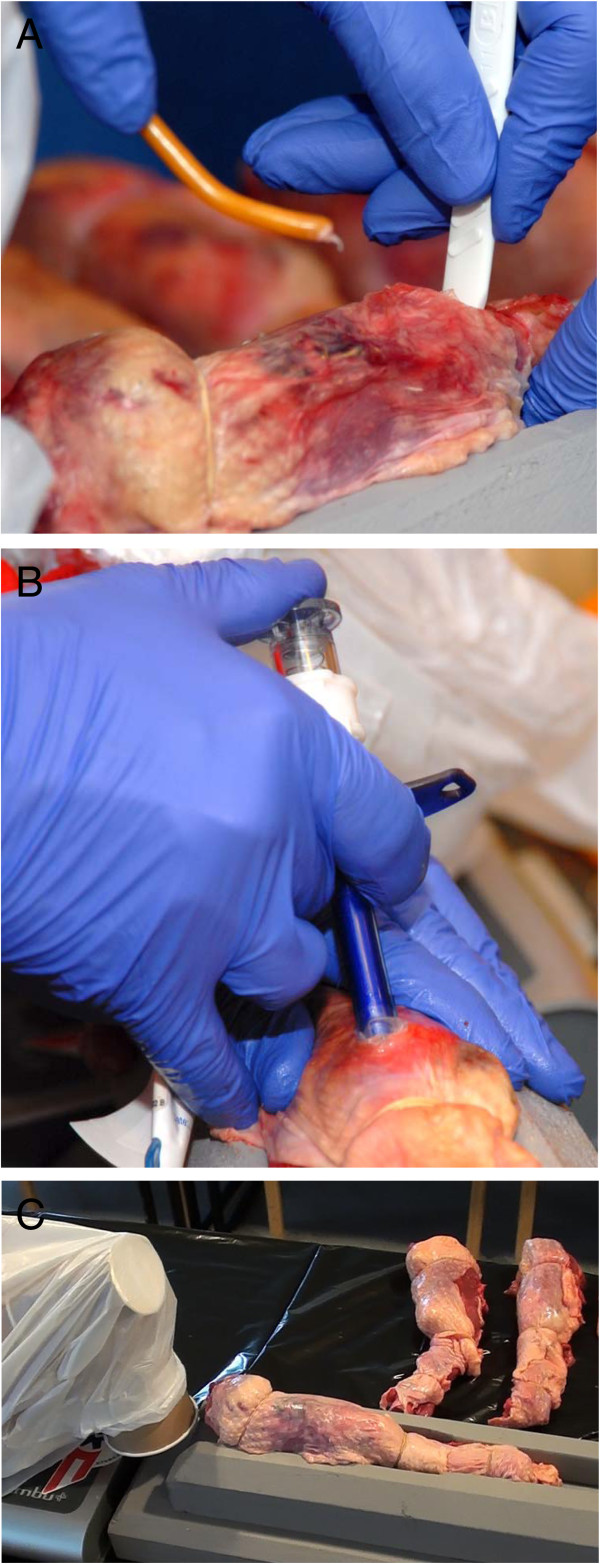
Simulated emergency cricothyrotomy in a cadaveric porcine model. A) The picture shows the perforation of the cricothyroid membrane in the BACT technique performed in the porcine airway model. B) The picture shows the perforation of the cricothyroid membrane with the PCK device in the porcine airway model. C) The porcine larynx is attached to a device and cranial space is limited by the prescience of the head of an airway simulator that is modified and orientated to mimic the anatomy of an adult male patient with flexion of the neck.